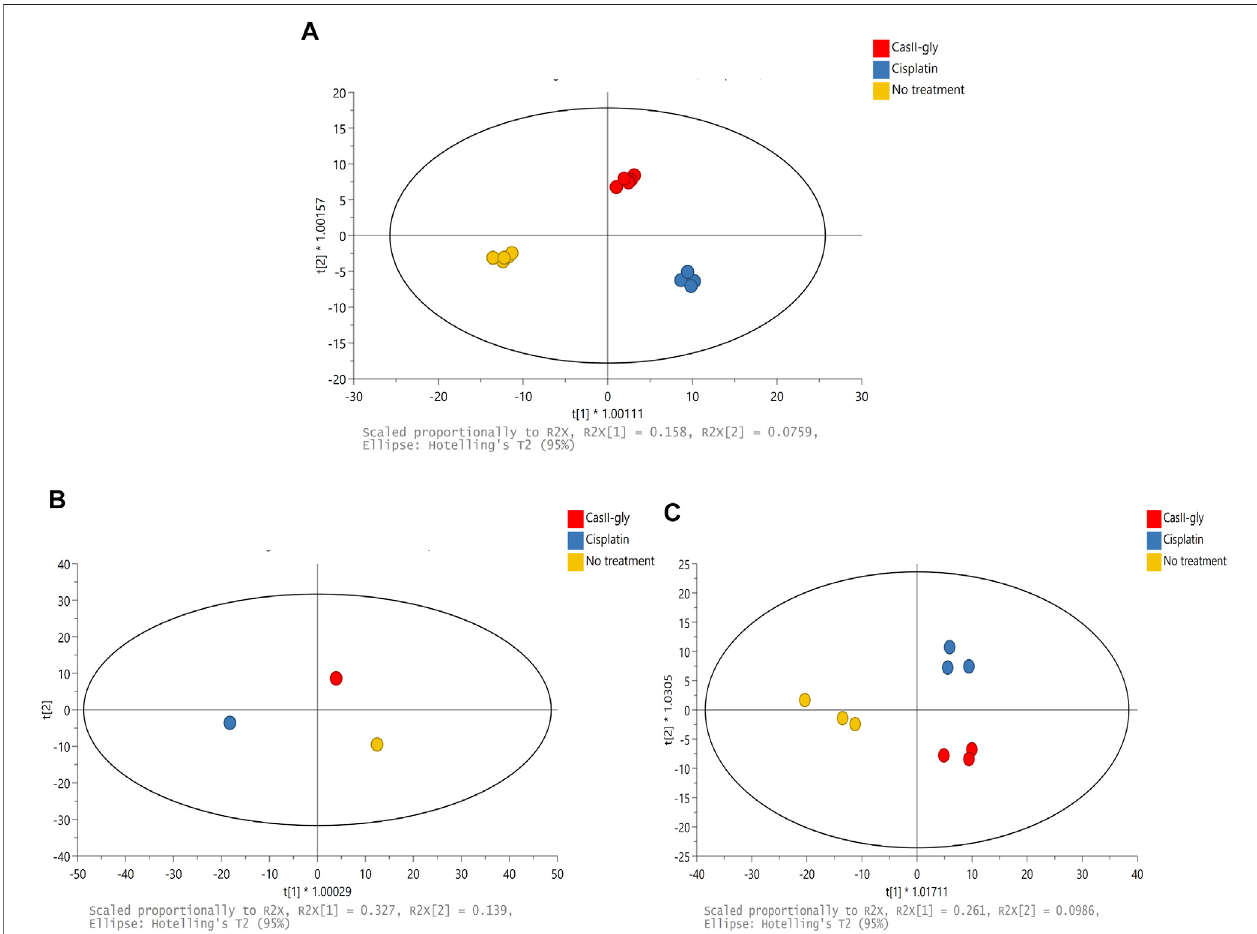
FIGURE 2 | (A) Scores of PCA of the 1 H-NMR spectral data for 20 and 40 min: no treatment (yellow), cisplatin (blue), and CasIIgly (red). (B) Scores of OPLS-DA of the 1 H-NMR spectral data for 20 min: no treatment (yellow), cisplatin (blue), and CasIIgly (red). (C) Scores of OPLS-DA of the 1 H-NMR spectral data for 40 min: no treatment (yellow), cisplatin (blue), and CasIIgly